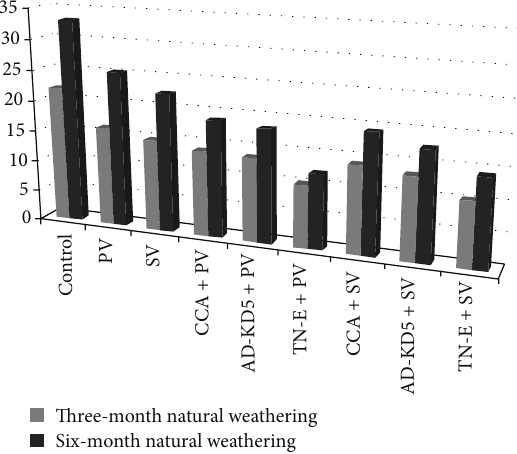
Figure 3: Total color changes ( Δ𝐸 ) of Scots pine after 3- and 6- month natural weathering. Note: it is drawn by using the average value of Δ𝐸 . See Table 4 for standard